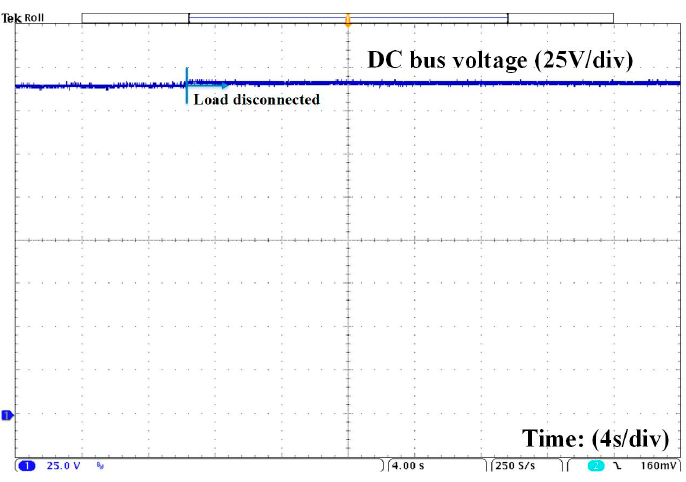
Figure 19. Connection of 300 W fluorescent lamps.